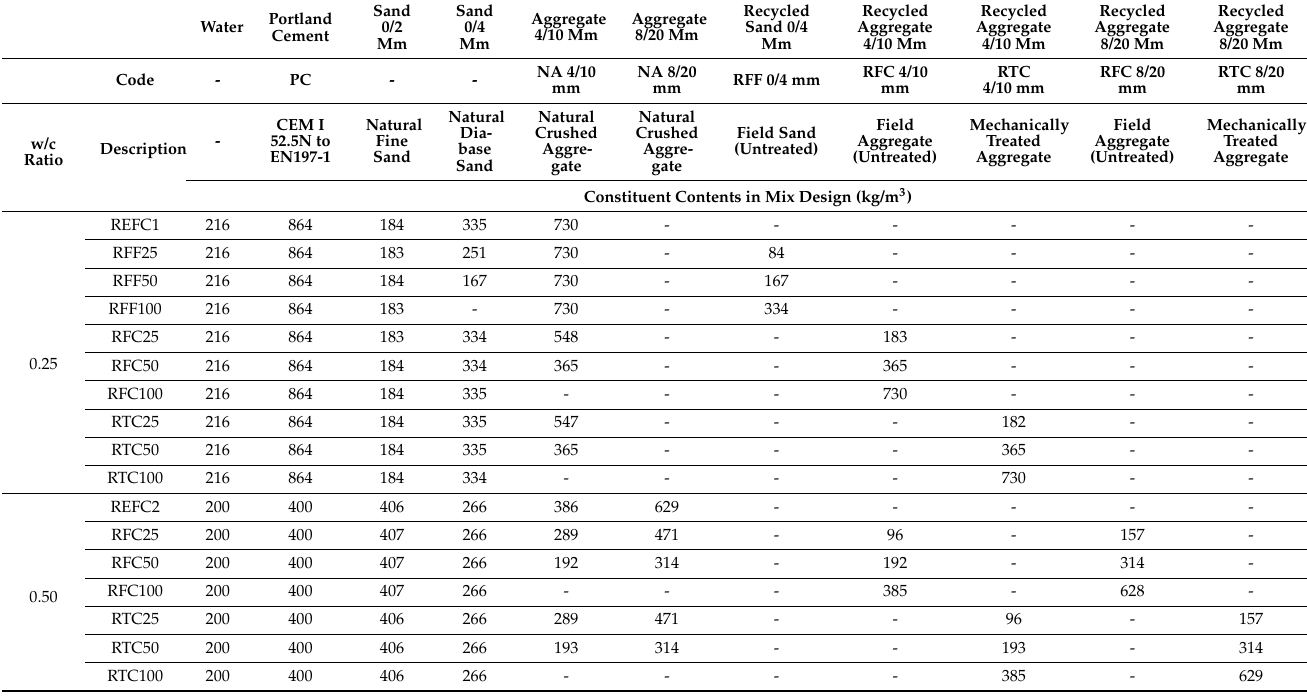
Table 3. Mix proportions, nomenclature and replacement percentages of RCA in concrete